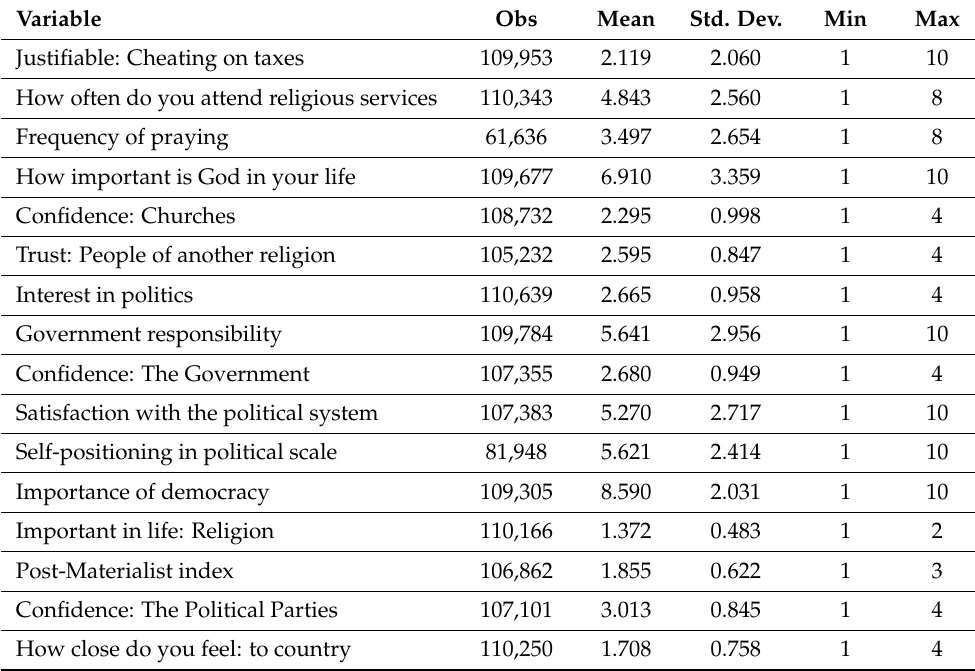
Table A1. Summary statistics of the ordinal variables in the